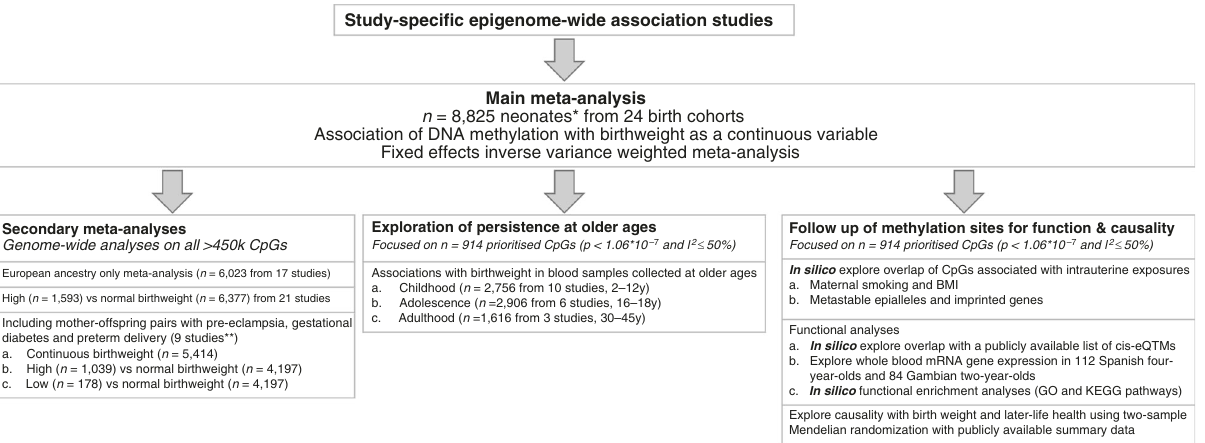
Fig. 2 Design of the study. Schematic representation of the main meta-analysis, secondary meta-analyses, follow-up analyses and exploration of persistence at older ages. *We removed multiple births from all analyses and excluded preterm births (<37 weeks) and offspring of mothers with pre- eclampsia or diabetes (three major pathological causes of differences). **For suf fi cient power in the low vs normal BW analyses, we only included nine